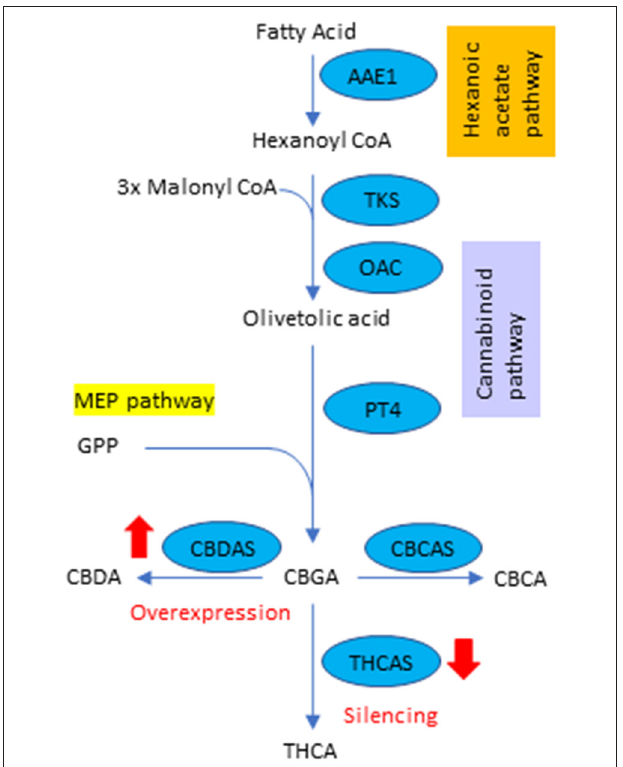
FIGURE 1 | The schematic pathway of phytocannabinoid synthesis and target genes in